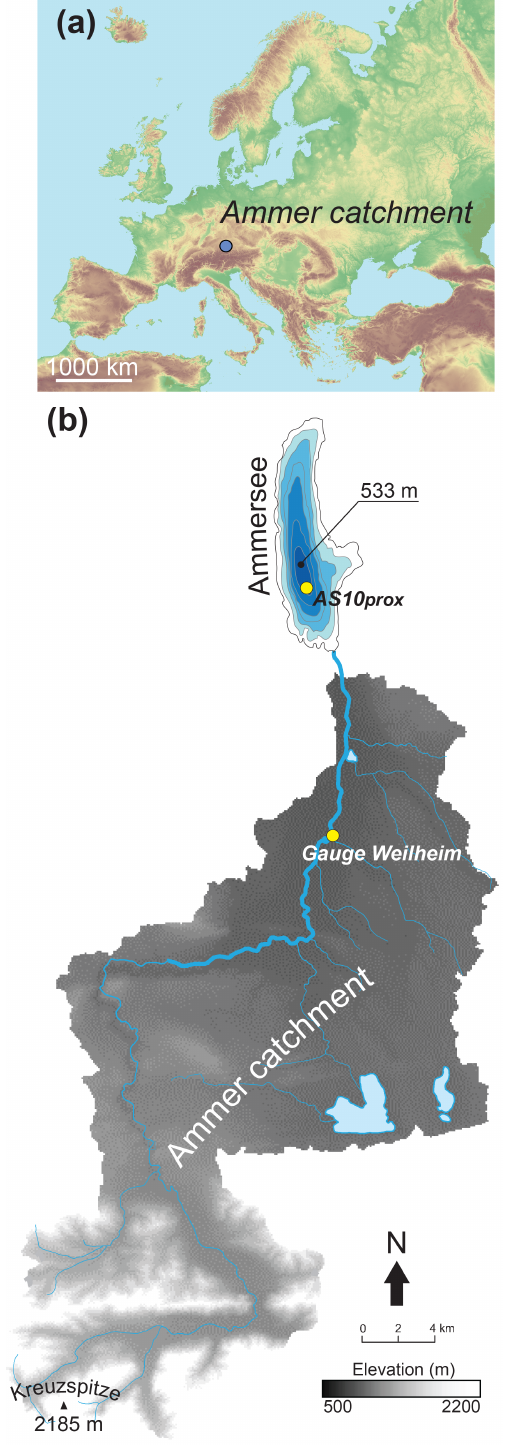
Figure 1. (a) Geographical position of the Ammer catchment. (b) Hydrological map of the Ammer catchment (modified after Lud- wig et al., 2003) and bathymetric map of the Ammersee with posi- tions of Gauge Weilheim and sediment core AS10 prox